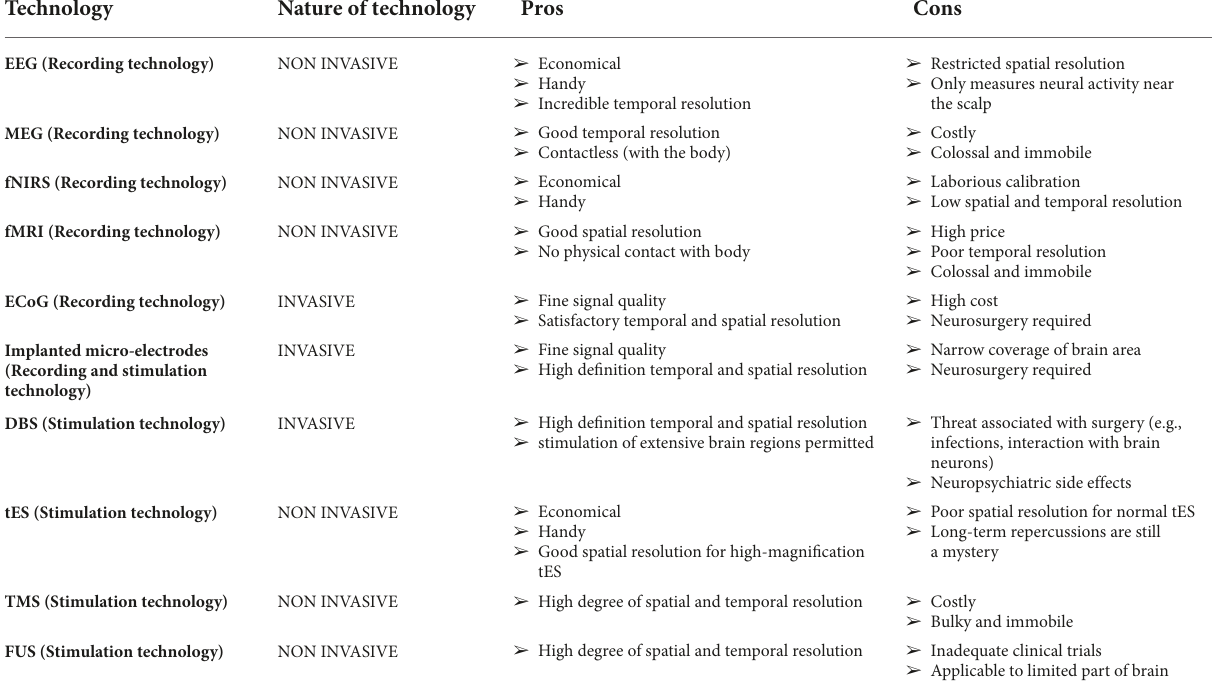
TABLE 1 Pros and Cons of various neuroscientific tehcniques for monitoring and altering brain activities.